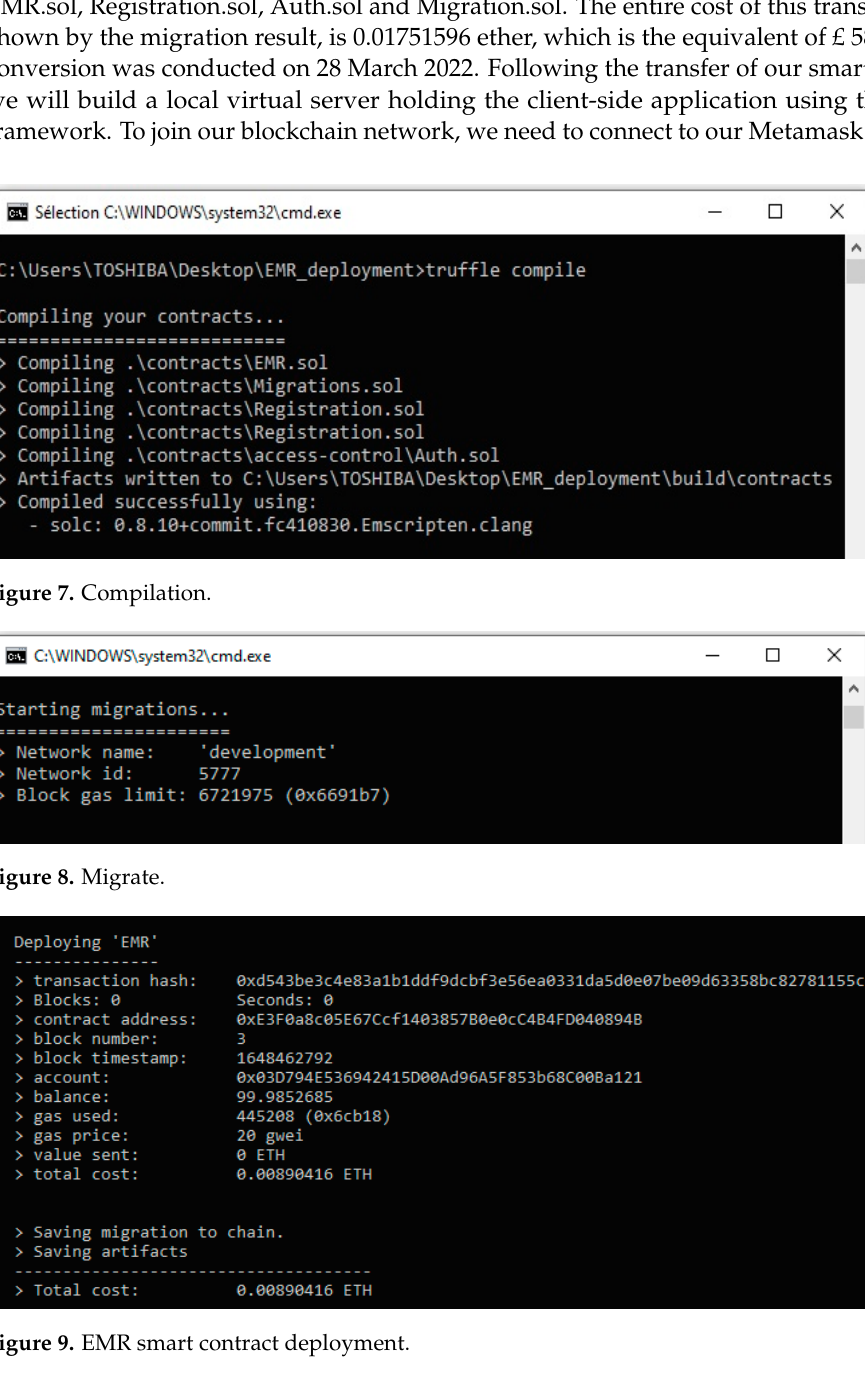
Figure 10. Registration smart contract deployment.